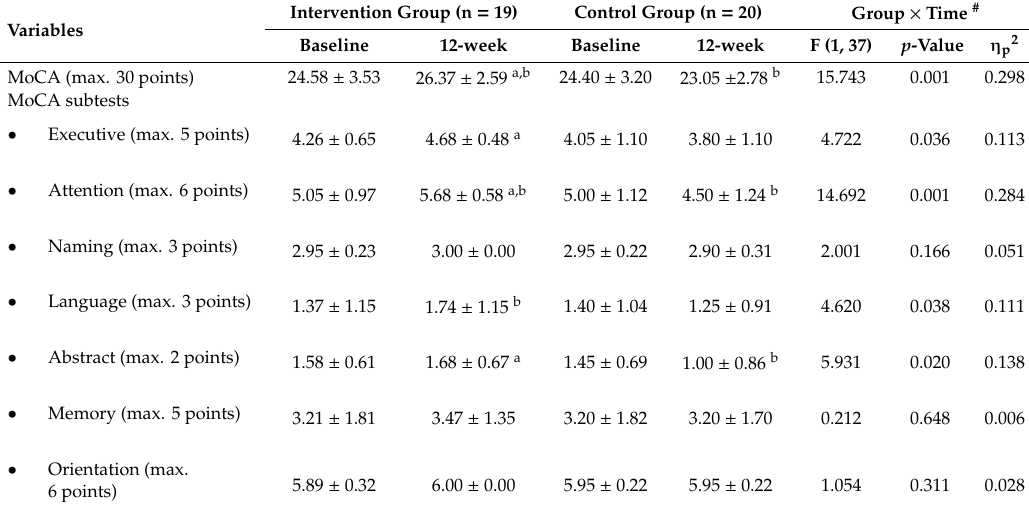
Table 4. Cognitive performance between the combined physical-cognitive training and control groups at baseline and the end of the 12 weeks. Intervention Group (n = 19) Control Group (n = 20) Group × Time # Variables Baseline 12-week Baseline 12-week F (1, 37) p -Value η p 2 MoCA (max. 30